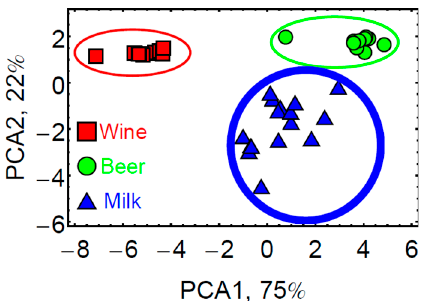
Figure 7. Classification of complex mixtures by the eT based on principal component analysis (PCA) with the two principal components representing 97% of the variance. Reprinted from [29].